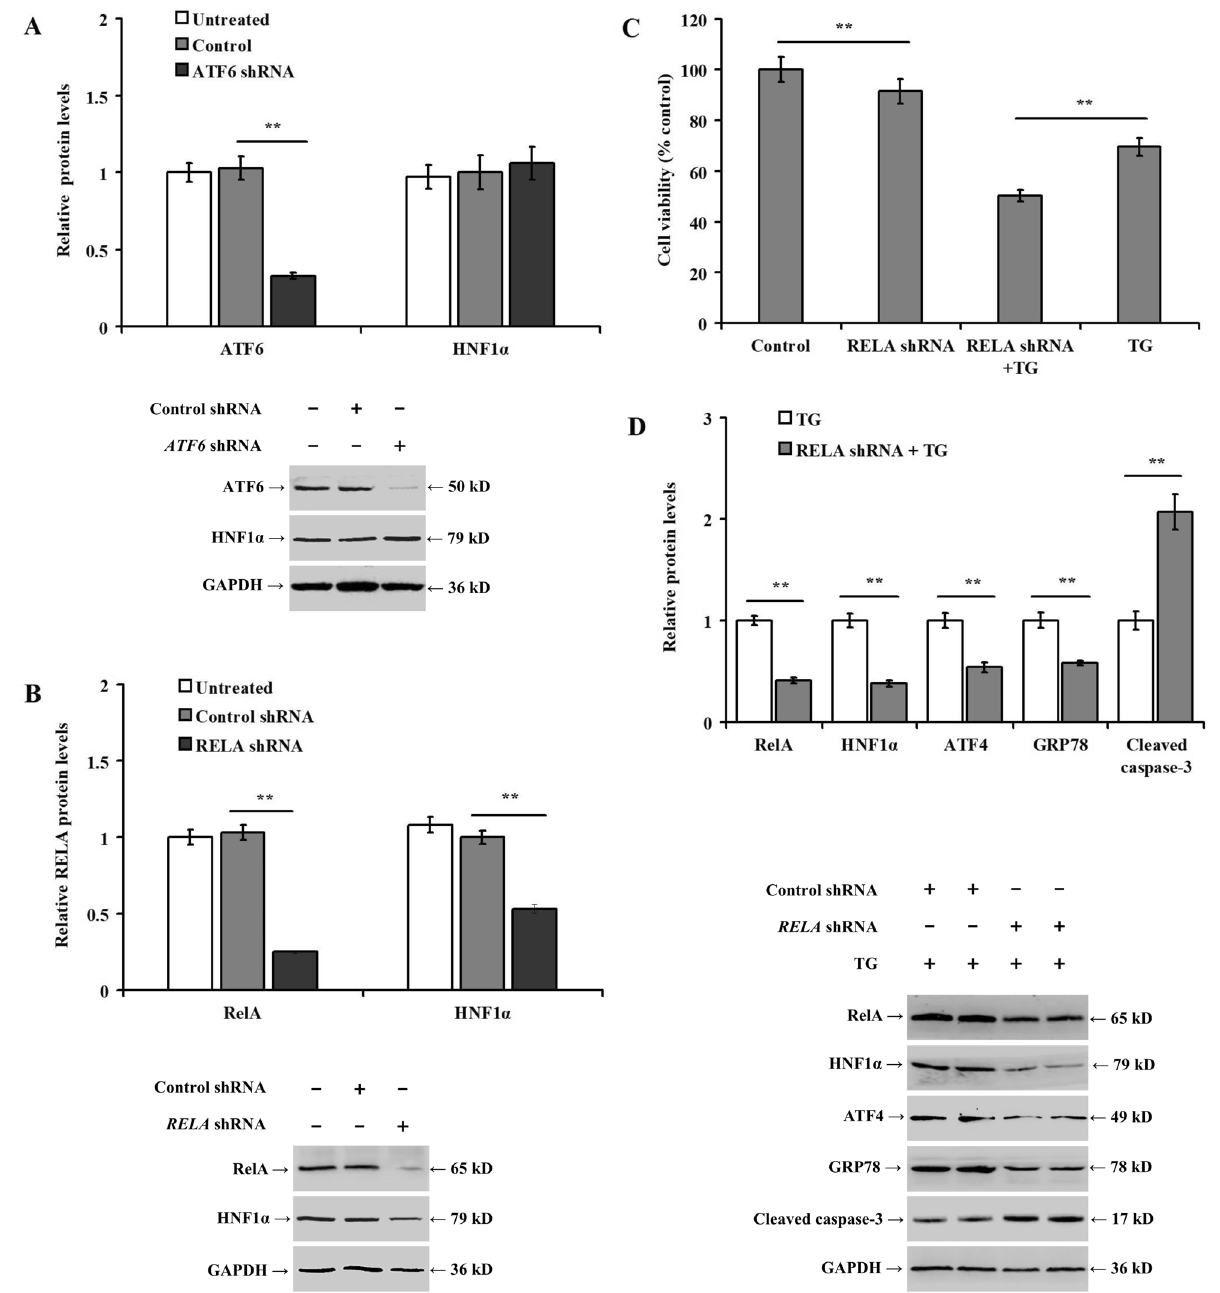
Figure 4. Knockdown of RELA inhibits TG-induced HNF1α expression in LO2 cells. LO2 cells were pretreated with control shRNA, ATF6 shRNA, or RELA shRNA for 48 h, and then incubated with or without TG (1.0 μmol/L) for 36 h: ( A ) bar chart and representative western blotting showing the alteration in ATF6 and HNF1α expression after ATF6 shRNA transfection in LO2 cells; ( B ) bar chart and representative Western blotting showing the alteration in RelA and HNF1α expression after RELA shRNA transfection in LO2 cells; ( C ) bar chart representing the impact of RELA knockdown on LO2 cell viability; and ( D ) bar chart representing the relative protein expression and representative western blotting between the different experimental groups. ** p < 0.01, versus the control (control shRNA, or control shRNA + DMSO) or TG group (control shRNA +